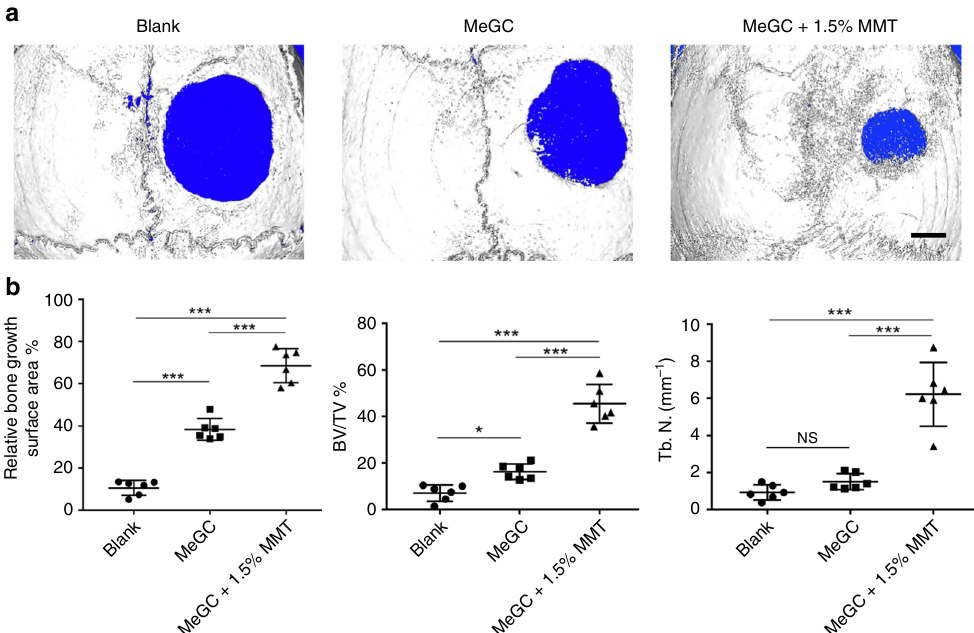
Fig. 8 Evaluation of in vivo bone regeneration. a Microcomputed tomography images of calvarial defects treated with hydrogels or left empty, 6 weeks post surgery, scale bar = 1 mm. b μ CT quanti fi cation of bone regeneration in calvarial defects. Relative bone growth surface area, bone volume density (BV/TV%), and the trabecular number (Tb.N., mm − 1 ). * p < 0.05, *** p < 0.001, and NS, no signi fi cance (ANOVA followed by Tukey ’ s post hoc test). Error bars indicate standard deviation ( n = 6)